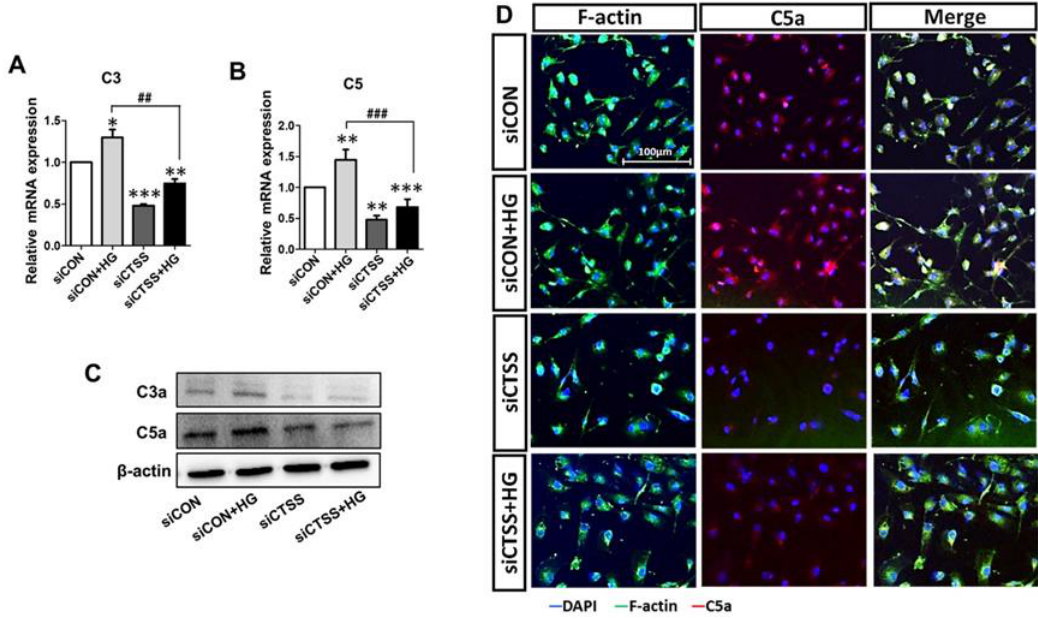
Figure 4. Treatment with cathepsin S (CTSS) siRNA suppressed complement factor activation. ( A , B ) Expression of complement C3 and C5 genes and ( C ) C3a and C5a proteins after CTSS siRNA transfection under high glucose conditions. ( D ) Immunofluorescence analysis of C5a. Values are expressed as mean ± SEM ( n = 3 biological replicates per group). p < 0.05 indicates statistical significance. * p < 0.05, ** p < 0.01, *** p < 0.001 versus control samples; ## p < 0.01, ### p < 0.001 versus HG-treated samples.